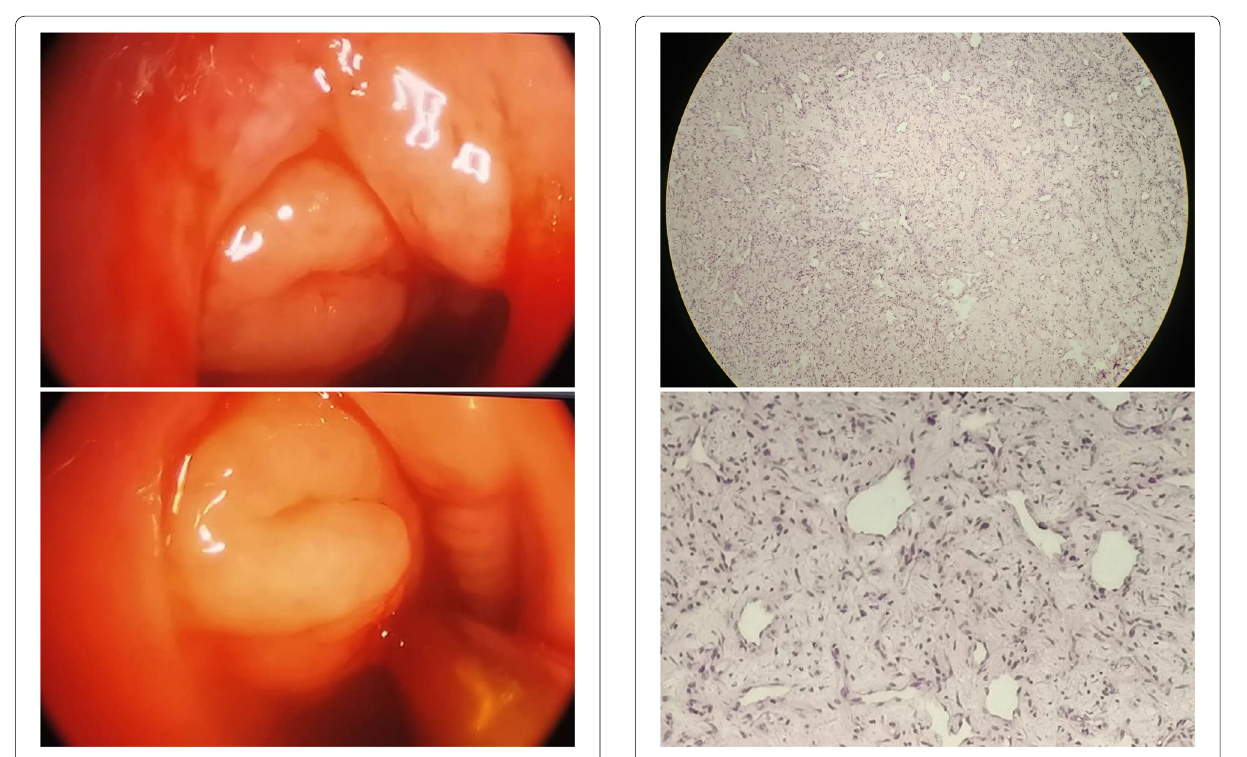
Fig. 4 Histopathological examination. Nasal angiofibroma which revealed (fibrous stroma with plump fibroblastic cells along with scattered capillaries)